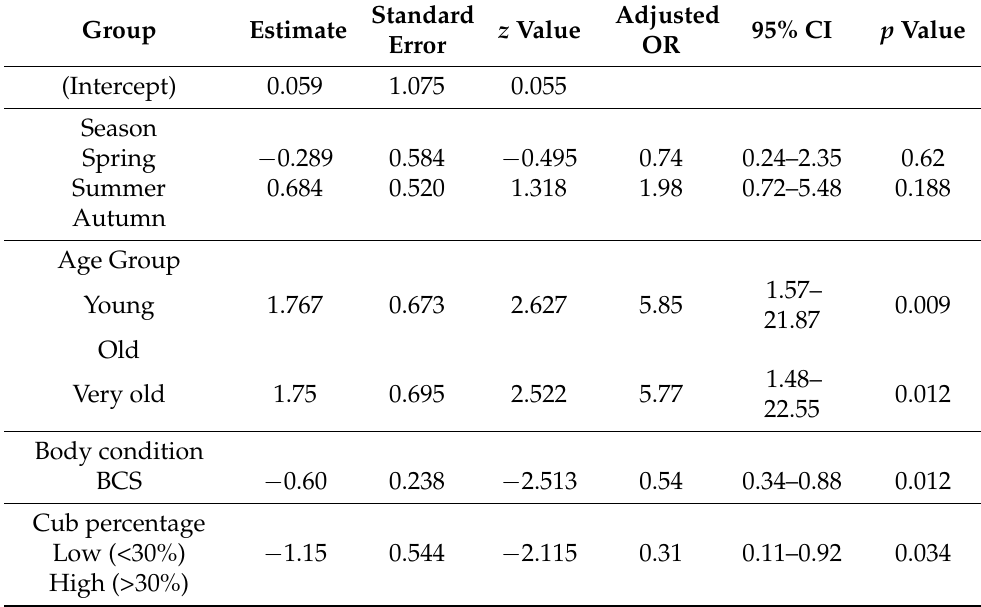
Table 4. Final general mixed effect model of multivariable logistic regression analysis for